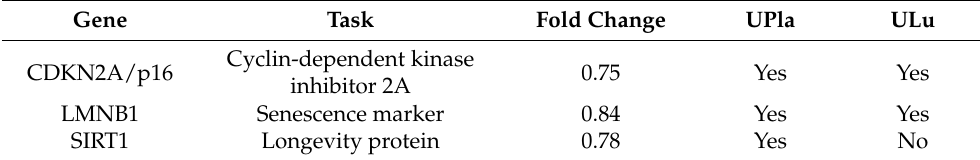
Table 3. Genes significantly downregulated by H 2 O 2 in HepG2